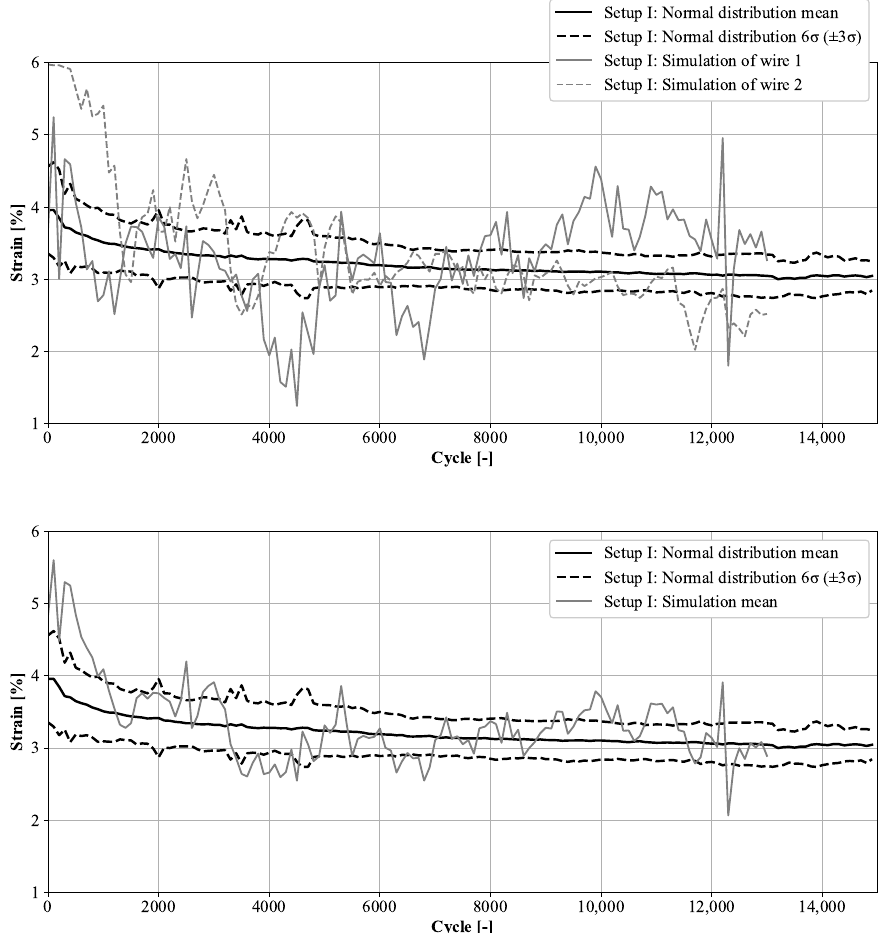
Figure 14. Target model for setup I based on the fatigue tests: Comparison of target model and 2 simulated wires ( Top ); Comparison of target model and the mean of the simulation ( Bottom